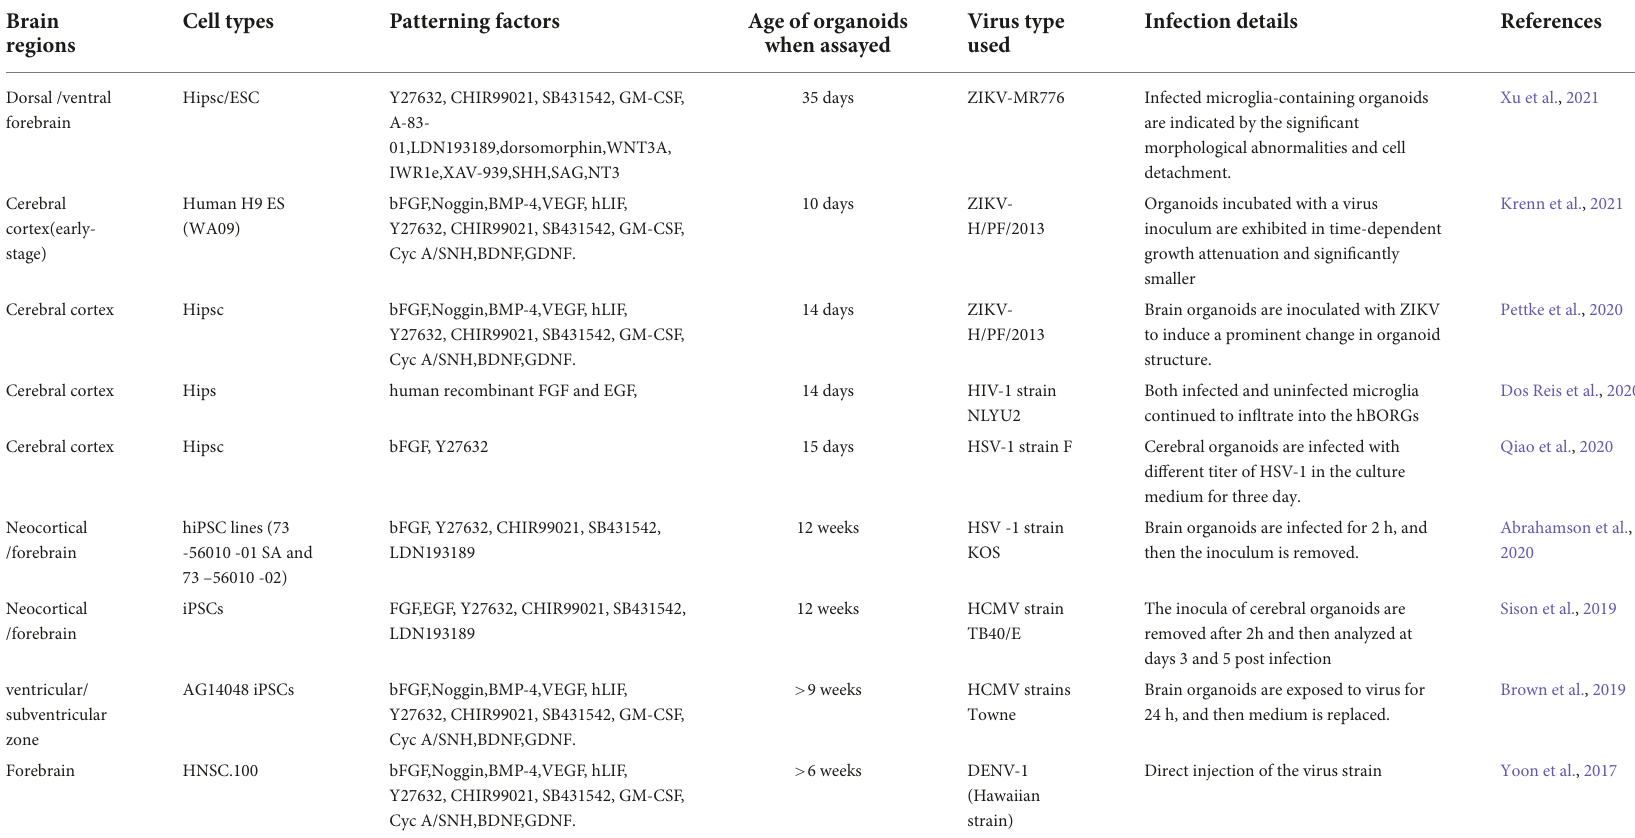
TABLE 1 Applications of brain organoids in